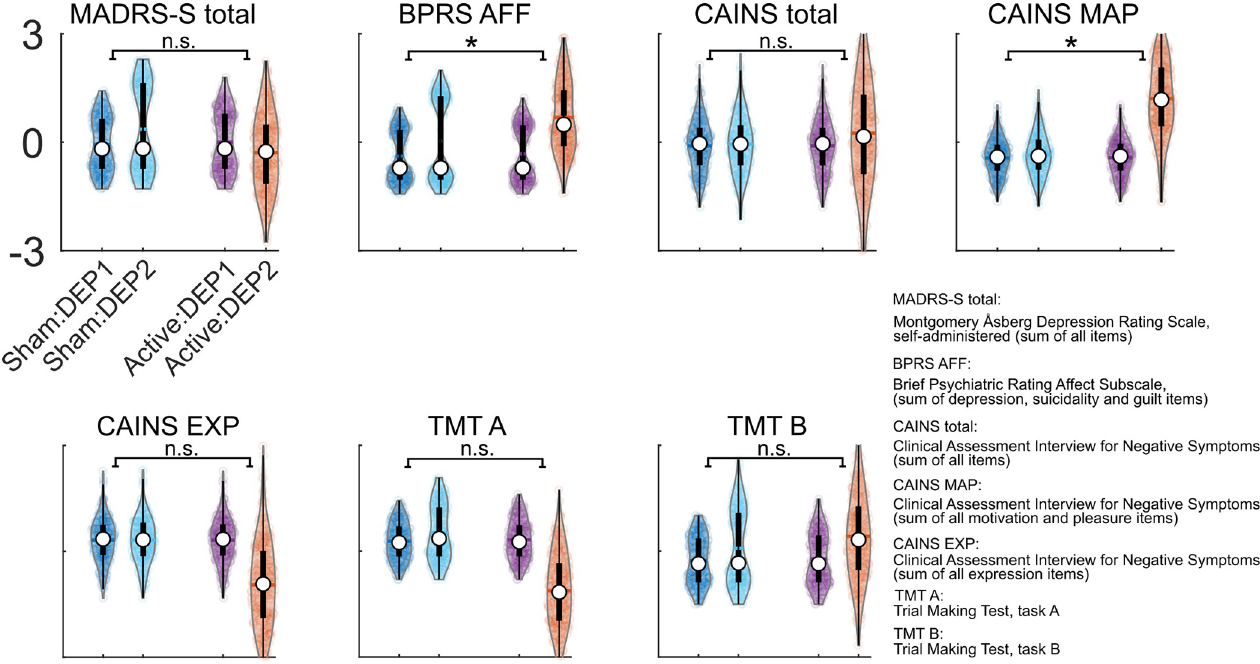
Fig 3. Depression subtypes modulate the changes in behavior. Violin plots show the distributions of changes in MADRS-S total, BPRS AFF, CAINS total, CAINS motivation and pleasure subscale (CAINS MAP), CAINS expression subscale (CAINS EXP), TMT A and TMT B across two depression subtypes and treatments. Within each violin plot, there is a box plot summarizing the bootstrap results by indicating the median (depicted by white dot), the first and third quadrants, represented by the lower and upper edges of the black box, and interquartile range by the whiskers. The dots within violin plots represent the resampled data points. Note, the full name of the behavioral measures can be found in the bottom right corner of the figure. ( Fig 3 ). Conversely, CAINS3 ( Frequency of Pleasurable Social Activities—Past Week ), 95% = [0.43, 1.52], CAINS 9 ( Frequency of Expected Pleasurable Recreational Activities– CI bootstrap = [1.85, 4.74], CAINS12 ( Expressive Gestures ), 95% CI = Next Week ), 95% CI bootstrap bootstrap [1.03, 2.69] and CAINS13 ( Quantity of speech ), 95% CI = [0.48, 1.32], had higher odd bootstrap ratio for DEP2 compared to DEP1 ( Fig 2 , lower row).